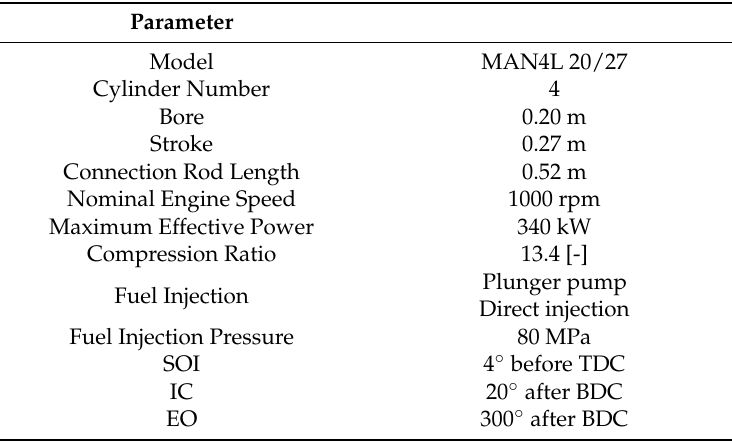
Table 1. The dimensions of engine used in the model.